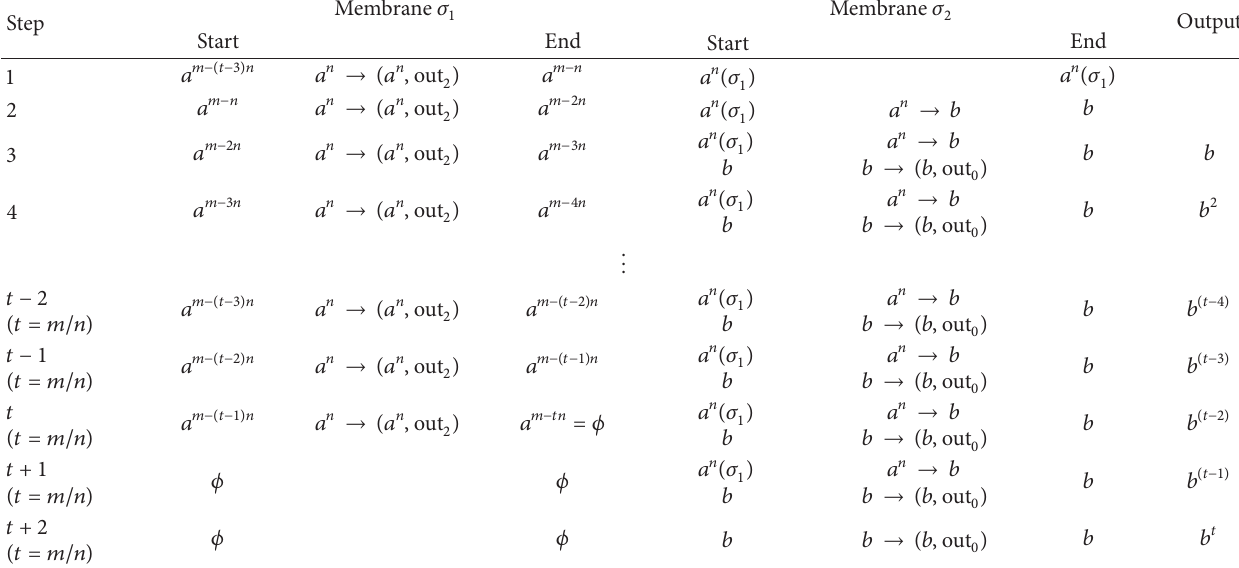
Table 2: The implementation of P chain system for exact division.